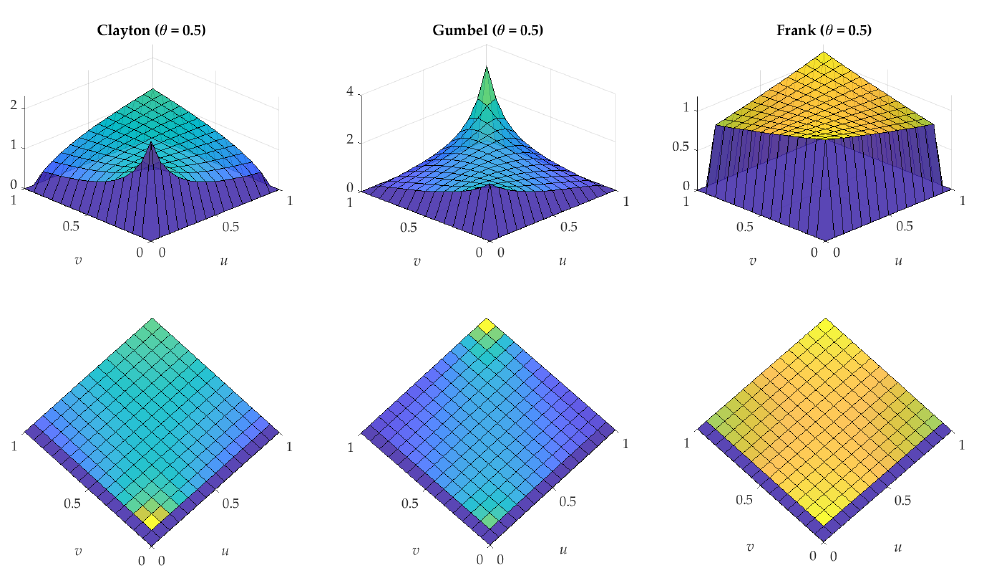
Figure 1. Plot of Archimedean copula